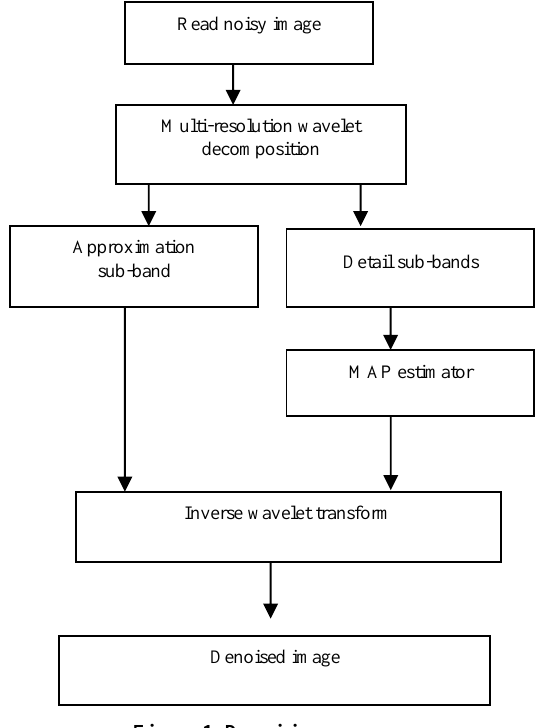
Figure 1. Denoising process.